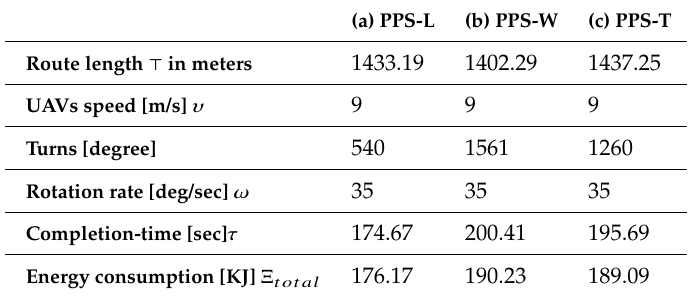
Table 9. Our CPP using our PPS-L partition method vs. PPS-W partition method vs. PPS-T partition method.